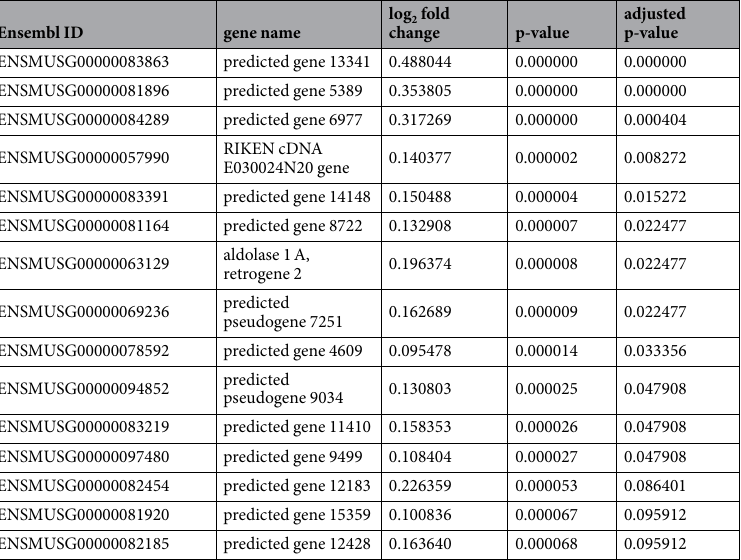
Table 1. Differential expression analysis of hippocampal gene expression data from CD and FD F1 mice. The table shows the top of the list of a differential expression analysis of hippocampal RNA sequencing data (adjusted p-value <